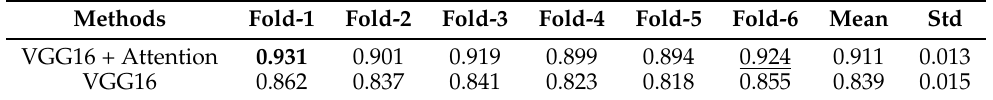
Table 4. Accuracy and standard deviation of our proposed model and plain VGG16 over 6-fold cross-validation. Each column in the table represents the fold number. The bold value represents the best performance among 6 folds, while the underline value shows the second best performance.